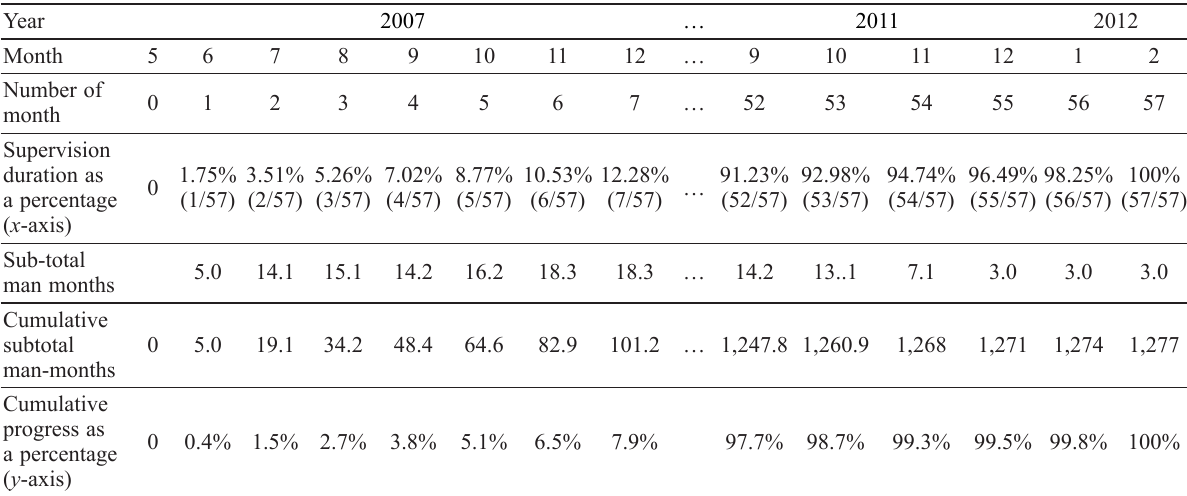
100%Fig. 2. Derived regression line of ES-curve in the planning Table 2. Data of the supervision duration and cumulative progress for the same example project shown in Table 1